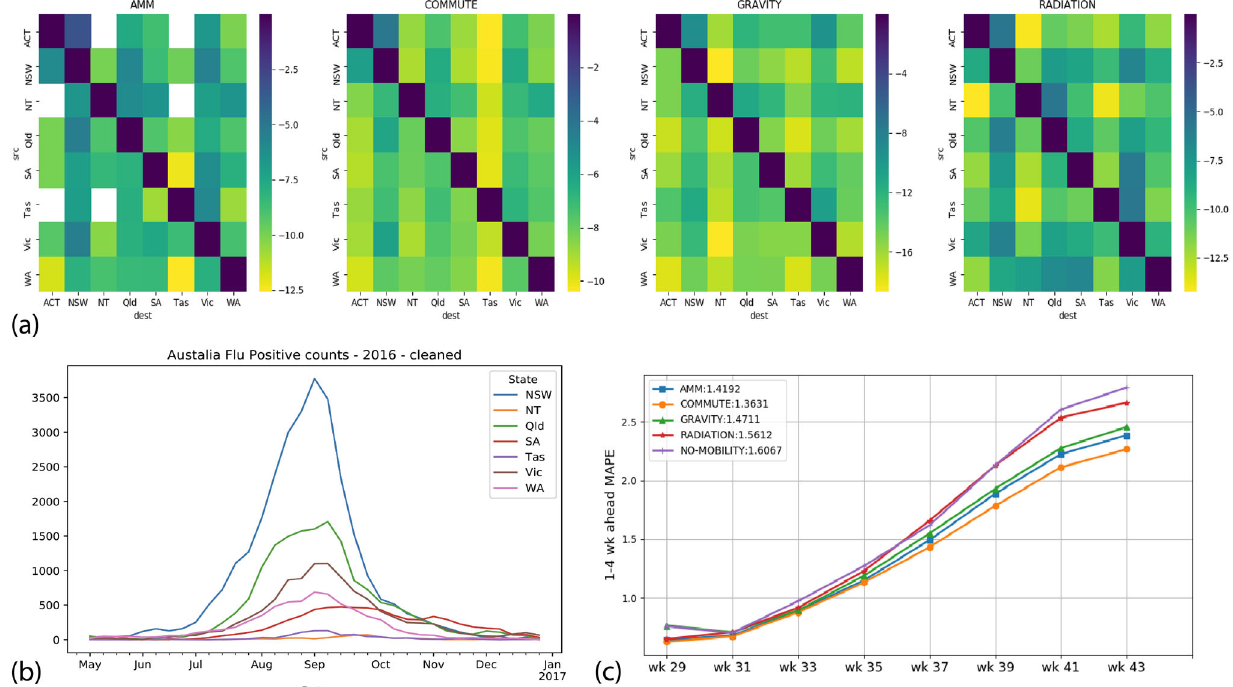
Fig. 8 Summary of results for Australia. a Mobility datasets for Australia: the heat maps show a comparison between the different mobility networks used for Australia at the state level. The reported values are the natural logarithm of the normalized fl ows. Note that while there is a signi fi cant self-loop component in all four networks, there is a higher similarity in magnitude and distribution between COMMUTE and AMM. b In fl uenza surveillance for Australia, 2016: the dataset obtained from Australia ’ s National Noti fi able Disease Surveillance System (NNDSS) shows fl u positive counts at State level aggregated to weekly resolution, with the baseline count removed (see Supplementary Methods for details). c Forecast performance comparison: similar to Fig. 4c, this fi gure shows the average MAPE across weeks for the four mobility networks (including the no mobility baseline). We see that all networks have similar performance with COMMUTE and AMM being the top two models. We also note that the NO MOBILITY baseline is not very different in performance, highlighting the sparsity of the